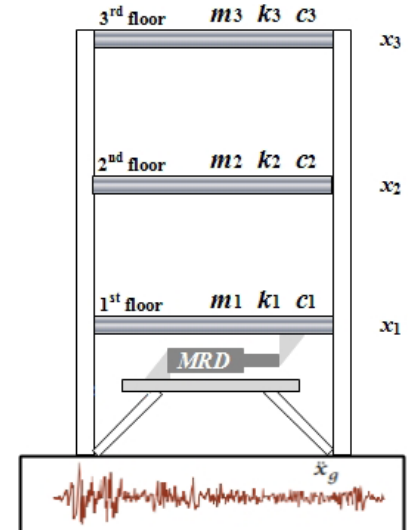
Figure 6. Tested scaled structure